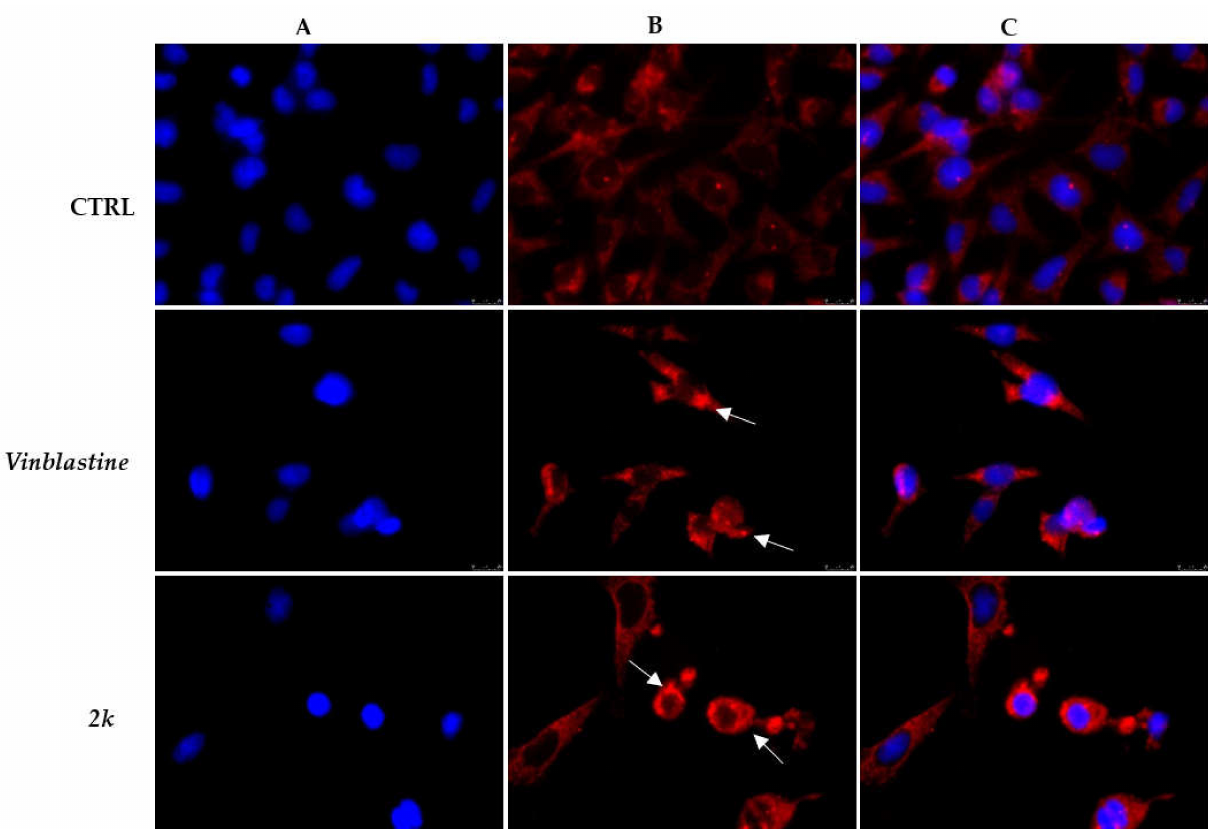
Figure 2. Immunofluorescence studies. Human melanoma A2058 cells were incubated with compound 2k , with vinblastine (both used at their IC 50 values), or with DMSO (CTRL) for 24 h. Cells were observed under the inverted fluorescence microscope at 40 × magnification. CTRL cells displayed a normal arrangement and organization of the tubulin cytoskeleton. Instead, A2058 cells treated with compound 2k and vinblastine exhibited an irregular microtubules organization (see white arrows). ( A ) nuclear stain with DAPI ( λ ex = 350 nm/ λ em = 460 nm); ( B ) β -tubulin (Alexa Fluor ® 568; λ ex = 644 nm/ λ em = 665 nm); ( C ) overlay channel. Representative fields are